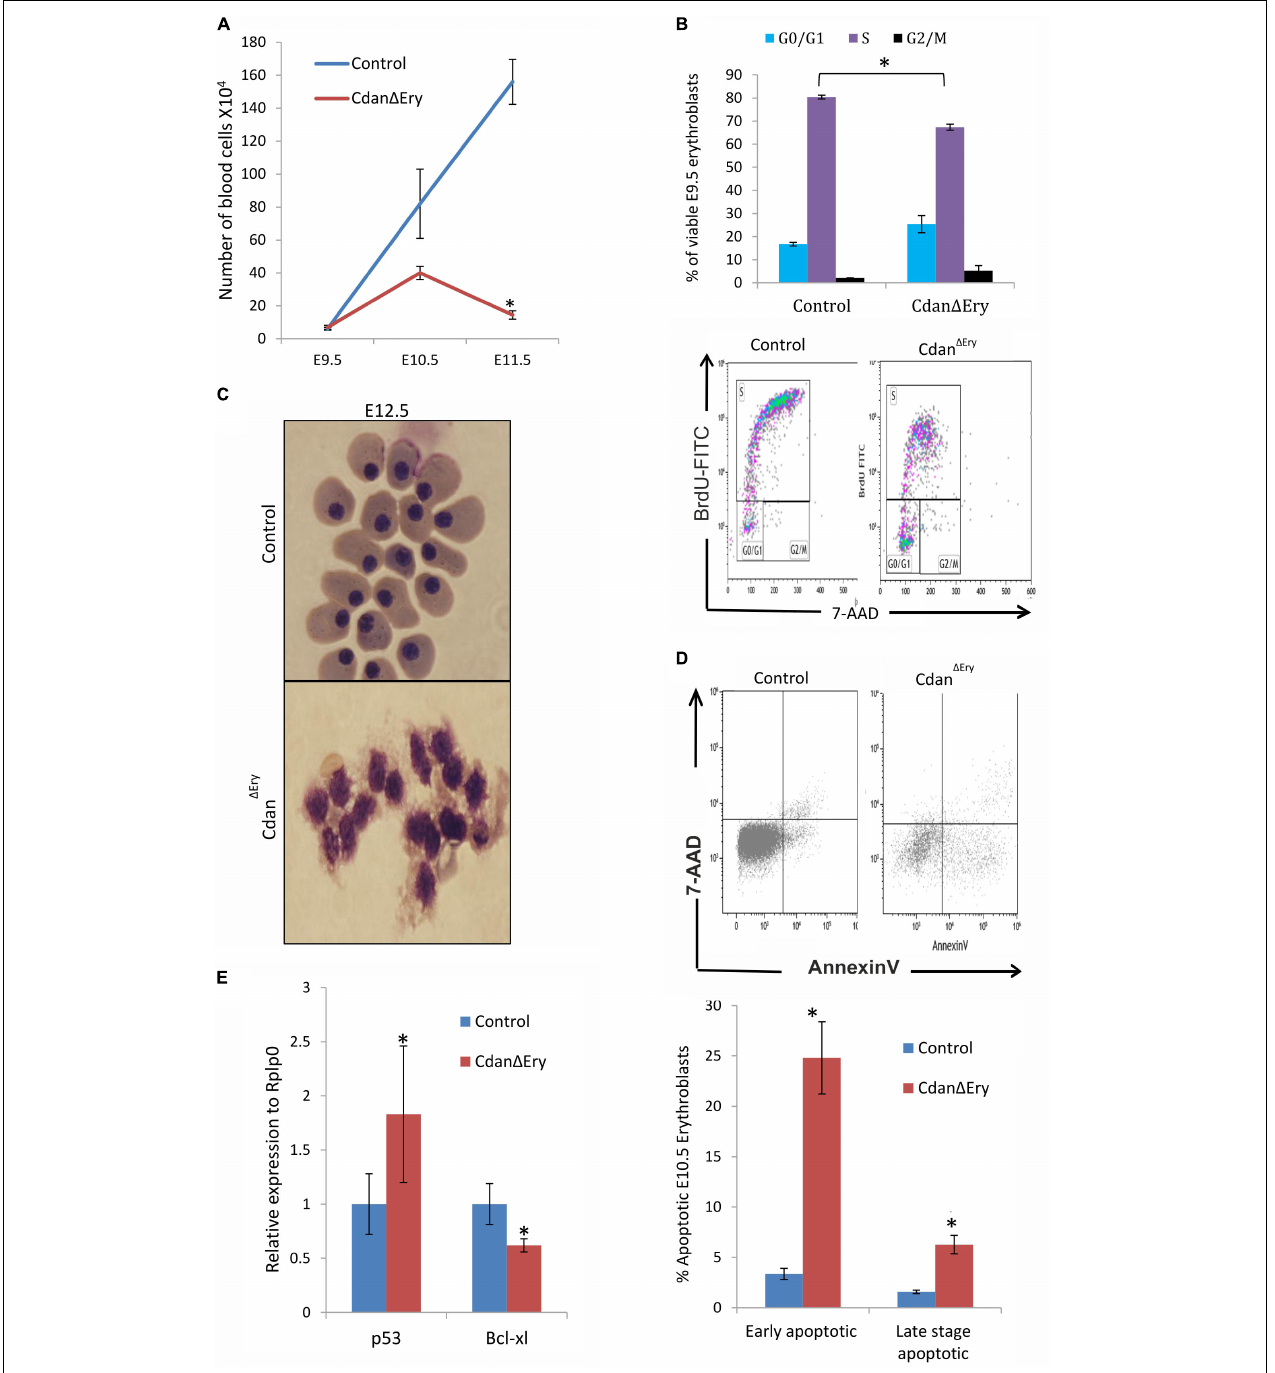
FIGURE 4 | Cdan1 depletion impairs cell cycle progression and increases cell death. (A) Number of circulating primitive erythroid cells collected from E9.5 to E11.5 control and Cdan (cid:49) Ery embryos. Values represent mean ± Standard error. Cdan (cid:49) Ery : n = 3; Control: n = 9. * p < 0.002 compared to controls. (B) Cdan (cid:49) Ery E9.5 erythroblasts show aberrant G1-to-S progression. The percentage of cells in G0/G1, S and G2/M phases of the cell cycle in wild-type (control) and Cdan (cid:49) Ery E9.5 erythroblasts gated for the CD71 + /Ter119 + population. Cdan (cid:49) Ery n = 3; control n = 12. Error bars indicate standard error. * p < 0.02 compared to wild-type. (C) Morphology of E12.5 Cdan (cid:49) Ery circulating erythroblasts, compared to littermate controls. (D) E10.5 peripheral blood cells were gated for CD71 + /Ter119 + erythroblasts, and analyzed for AnnexinV/7AAD staining to assess for apoptosis (Representative flow plots are shown in upper panel). Early apoptotic cells are AnnexinV-positive/7-AAD-negative; Late apoptotic cells are double positive. Data presented as mean ± SEM (n = 3-4 for each genotype). * p < 0.005. (E) Cdan1 ablation decreases Bcl-xl expression and increases p53 levels. qRT-PCR was performed with RNA extracted from peripheral blood cells at E11.5 and normalized to Rplp0. Relative expression data are presented as mean ± SEM ( n = 4–6 for each genotype). Student’s t -test was applied for statistical analysis. Asterisks indicate significant difference from the Control. * p < 0.05.